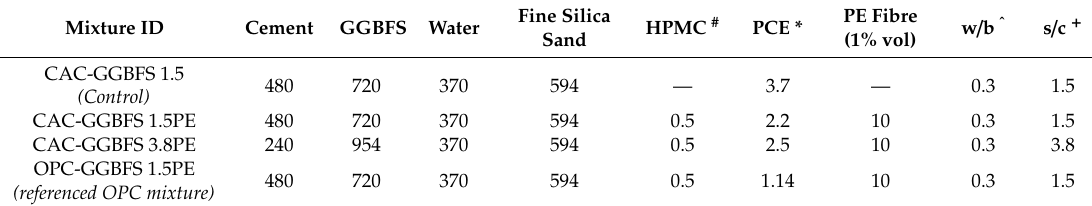
Table 2. Mix proportions of plain and PE fibre-reinforced mortar (kg/m 3 ) [17].